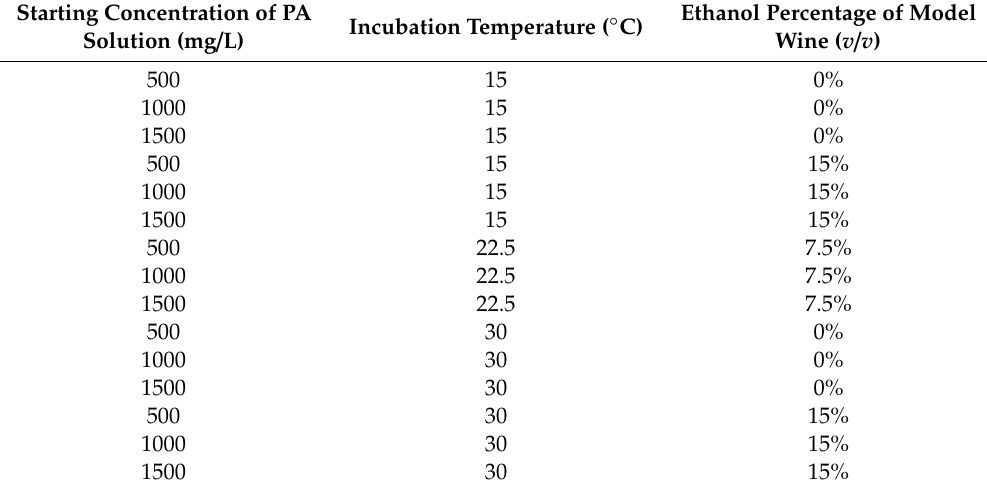
Table 2. Description of adsorption experiment parameters. All experiments contained 500 mg / L anthocyanin